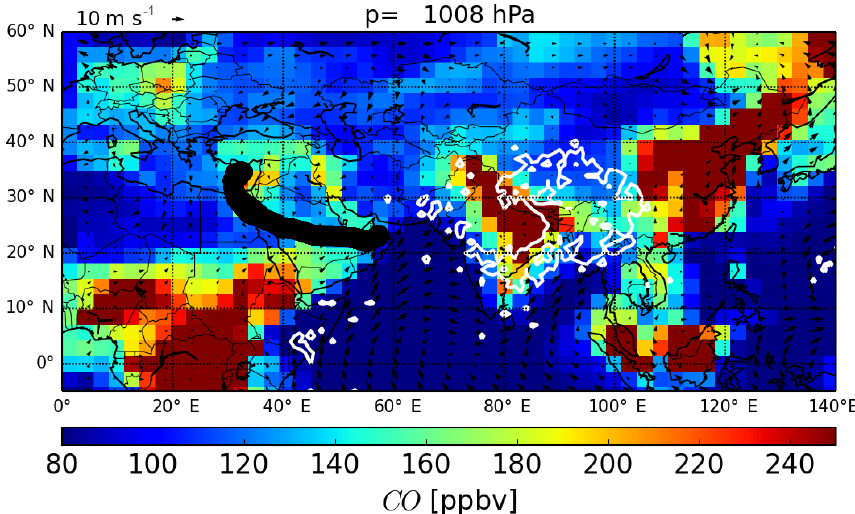
Figure 12. EMAC calculated CO; daily mean at the surface (1008hPa, 3 August 2015) as an indicator for surface emissions (10 days prior to measurement) and the flight track of flight 19 (black). Additionally, the footprint of the last boundary layer contact is shown as white contour line from Fig.